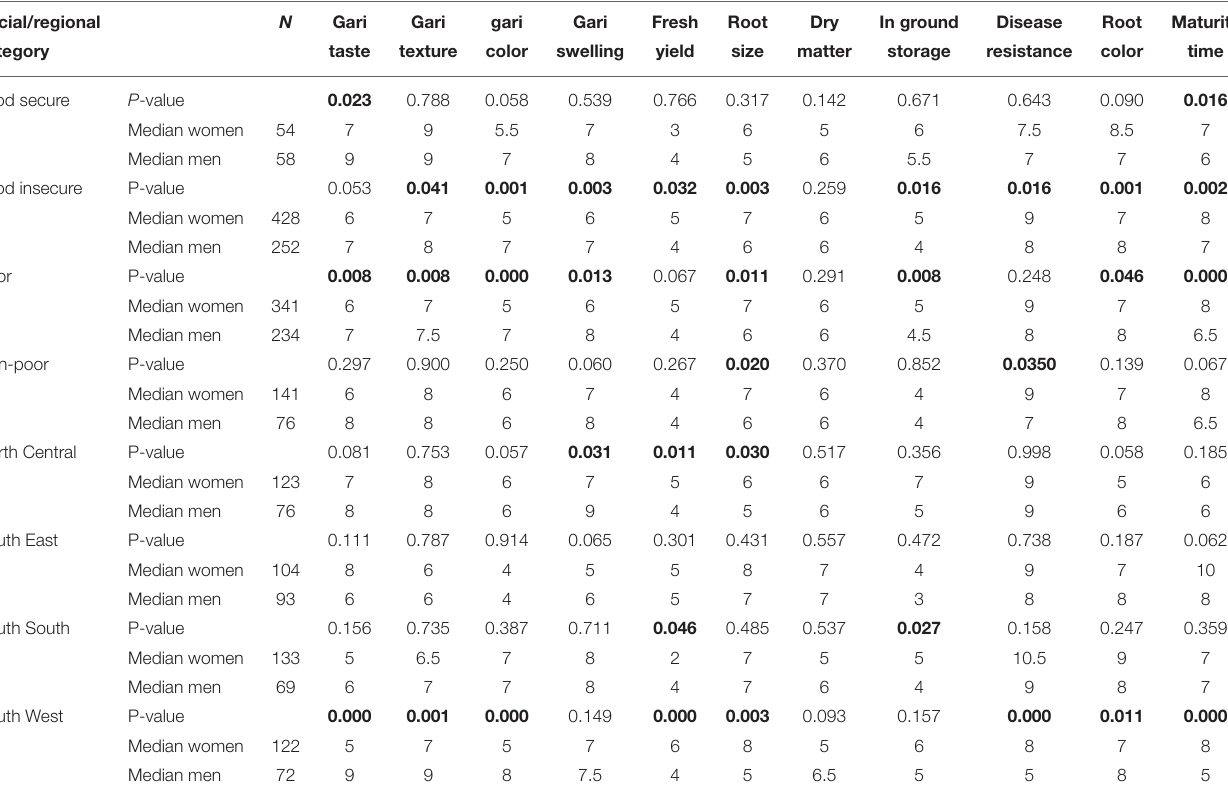
TABLE 4 | Wilcoxon test for independent samples comparing gender differences for trait prioritization within food security, poverty and regional differences. Social/regional N Gari Gari gari Gari